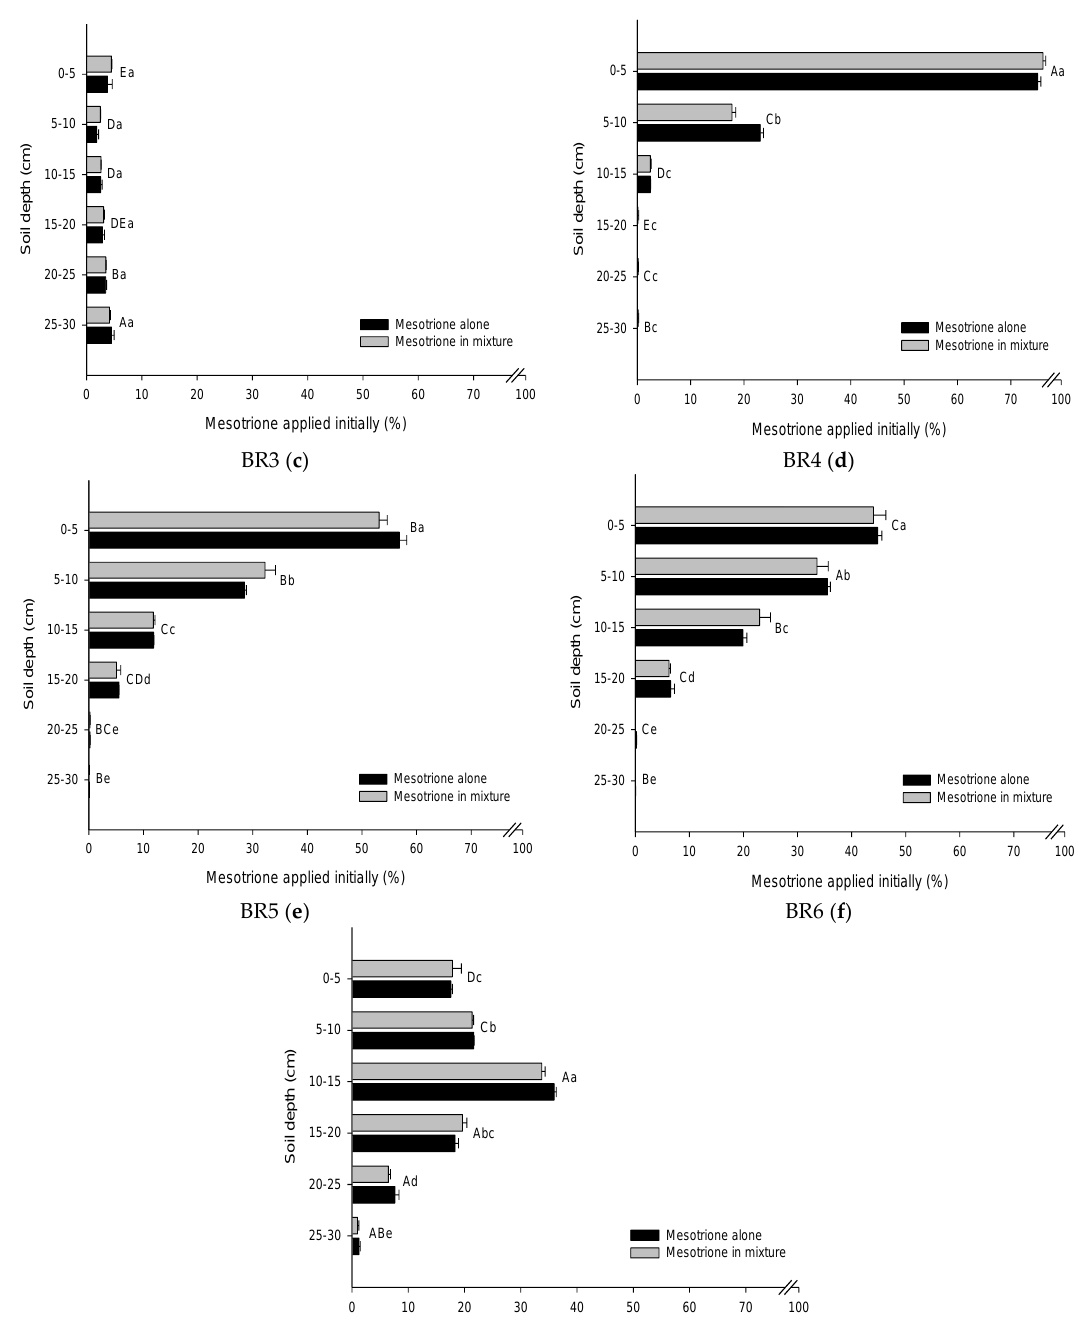
Figure 1. Percentage 14 C-mesotrione applied alone and in mixture with S-metolachlor and terbuthylazine in glass columns at different column heights (0–5, 5–10, 10–15, 15–20, 20–25 and 25–30 cm) and packed with tropical soils, represented by BR1 ( a ), BR2 ( b ), BR3 ( c ), BR4 ( d ), BR5 ( e ), BR6 ( f ) and BR7 ( g ) with simulation 200 mm of water for 48 h after application. The horizontal bars associated with each column represent the standard deviation (± SD) of each mean value ( n = 3). Means followed by the same tiny letter in each depth soil and capital in type soil do not differ by Tukey test ( p < 0.05). LSD, least significance difference (depth) = 3.2916, LSD (soil) = 3.4634 and CV (application type) = 1.60%, CV (soil) = 3.23% and CV (depth) = 12.66%.